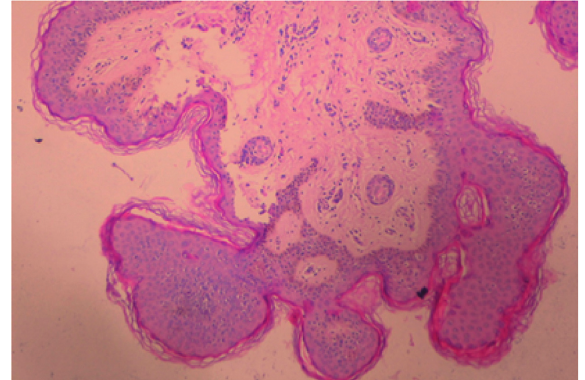
Figure 5: Skin biopsy: histological features of right skin lesions showed papillomatosis, acanthosis, and hyperkeratosis, which were consistent with verrucous epidermal nevus.